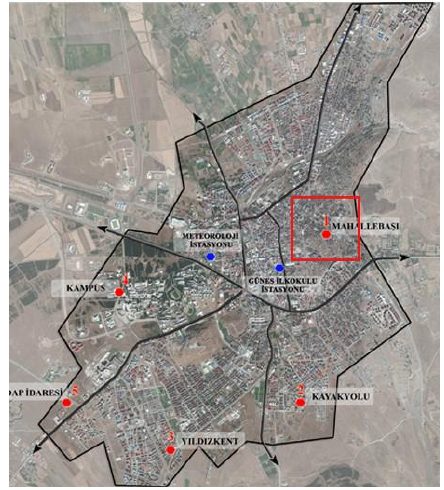
Figure 1. Satellite Image of the Study Area 1